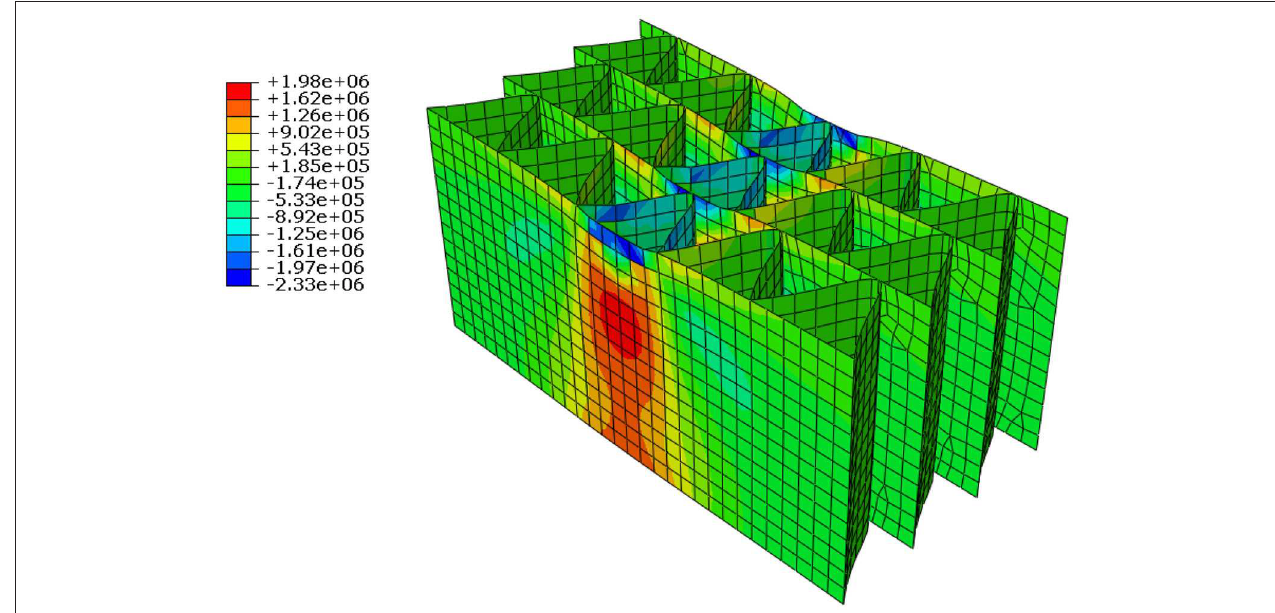
FIGURE 13 | Lateral stress (N/m 2 ) in geocell reinforcement (FEM data, s/B = 20%).